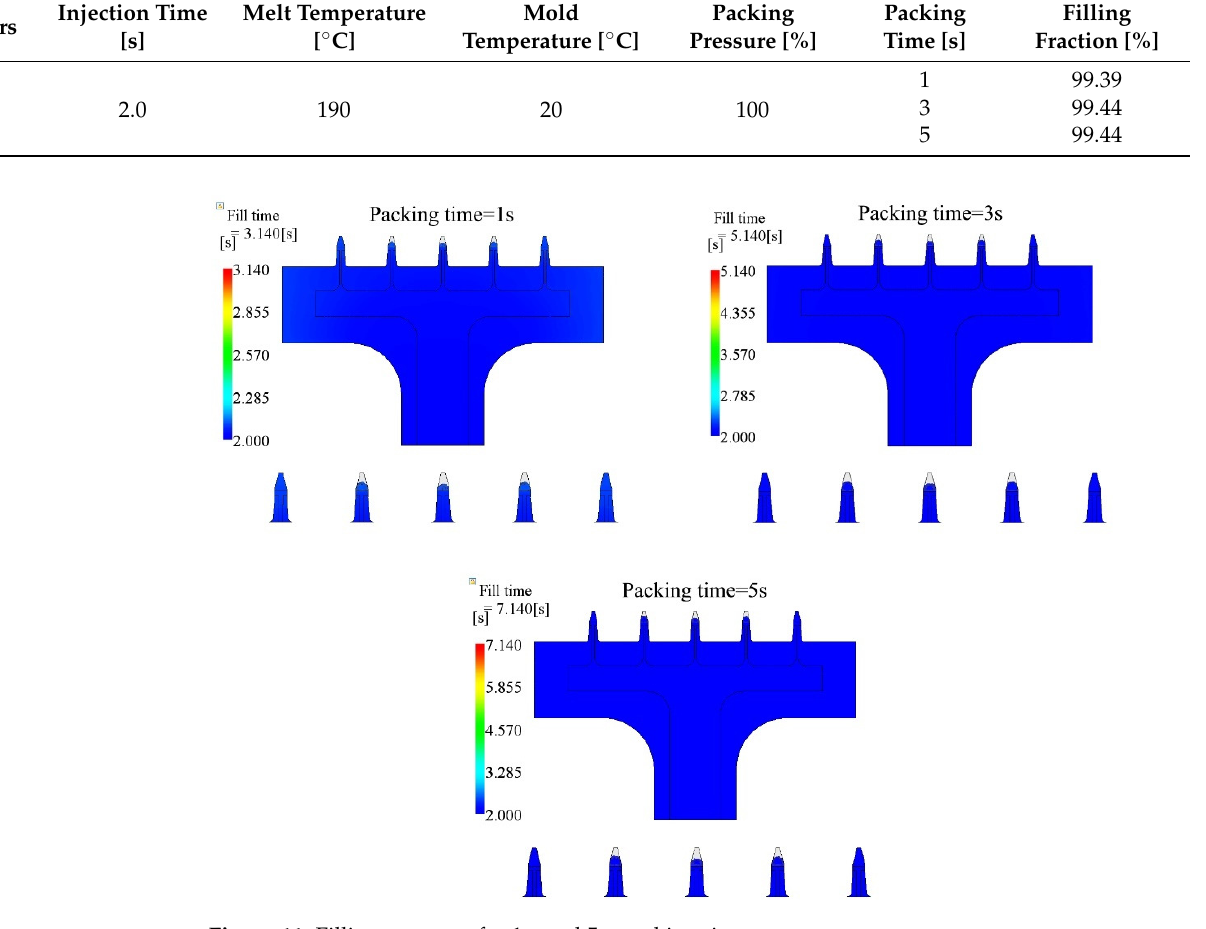
Figure 11. Filling contours for 1 s and 5 s packing time cases.